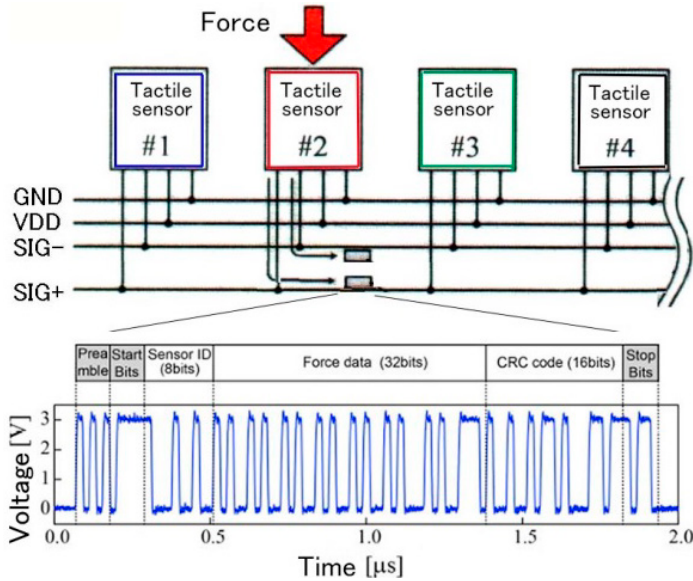
Figure 11. Fabrication process of the tactile force sensor on LSI.